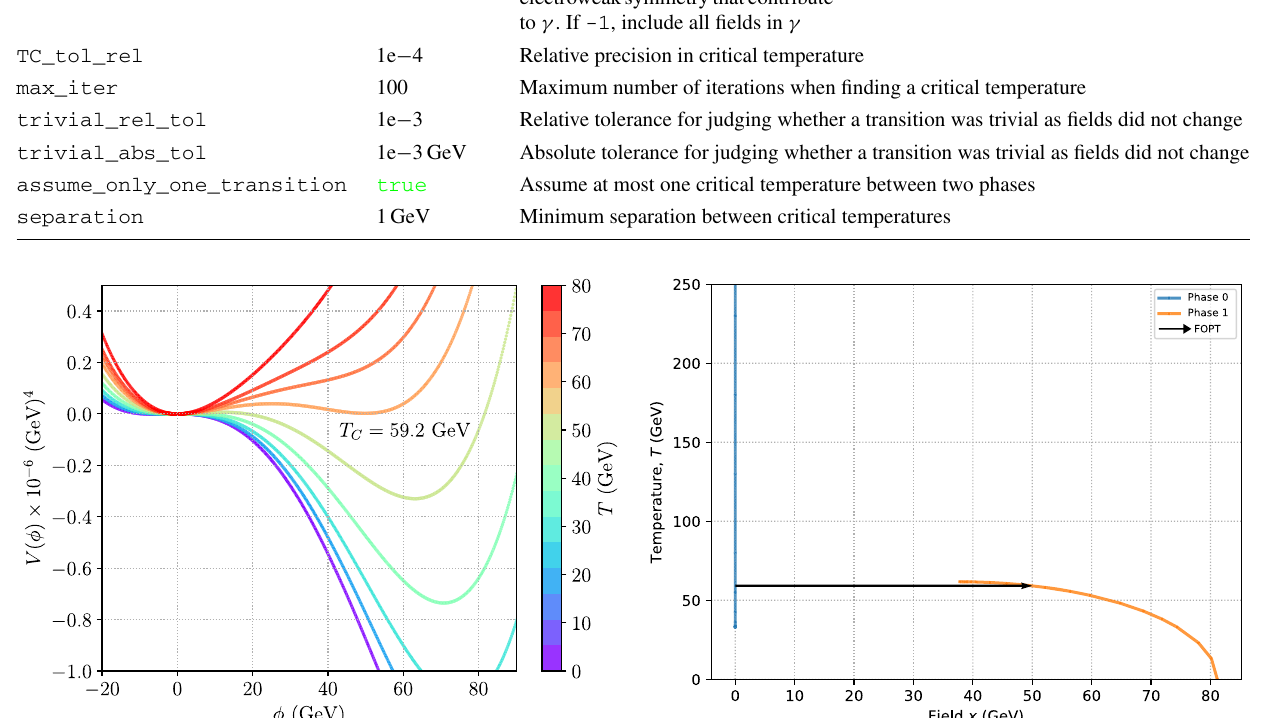
phases linked by the arrows are degenerate and thus that a FOPT could occur in the direction of the arrow. The label x was autogenerated by our plotting code. In this example it stands for